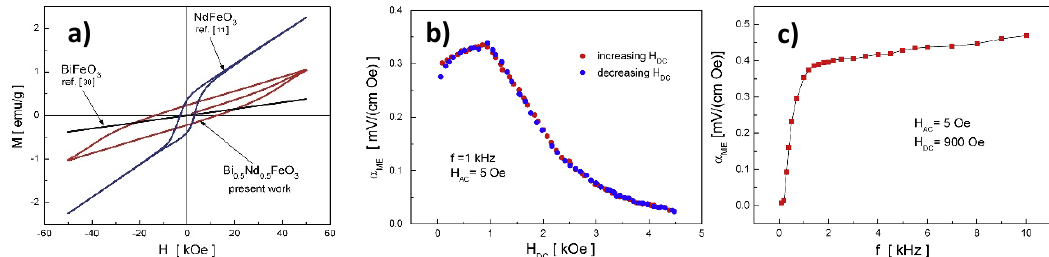
Figure 5. ( a ) Magnetic field dependence of the magnetization for the Bi 0.5 Nd 0.5 FeO 3 solid solution. ME coupling coefficient variation with: ( b ) static magnetic field H DC and ( c ) frequency f of sinusoidal magnetic field H AC for Bi 0.5 Nd 0.5 FeO 3 sample. Reproduced with permission from [23] .